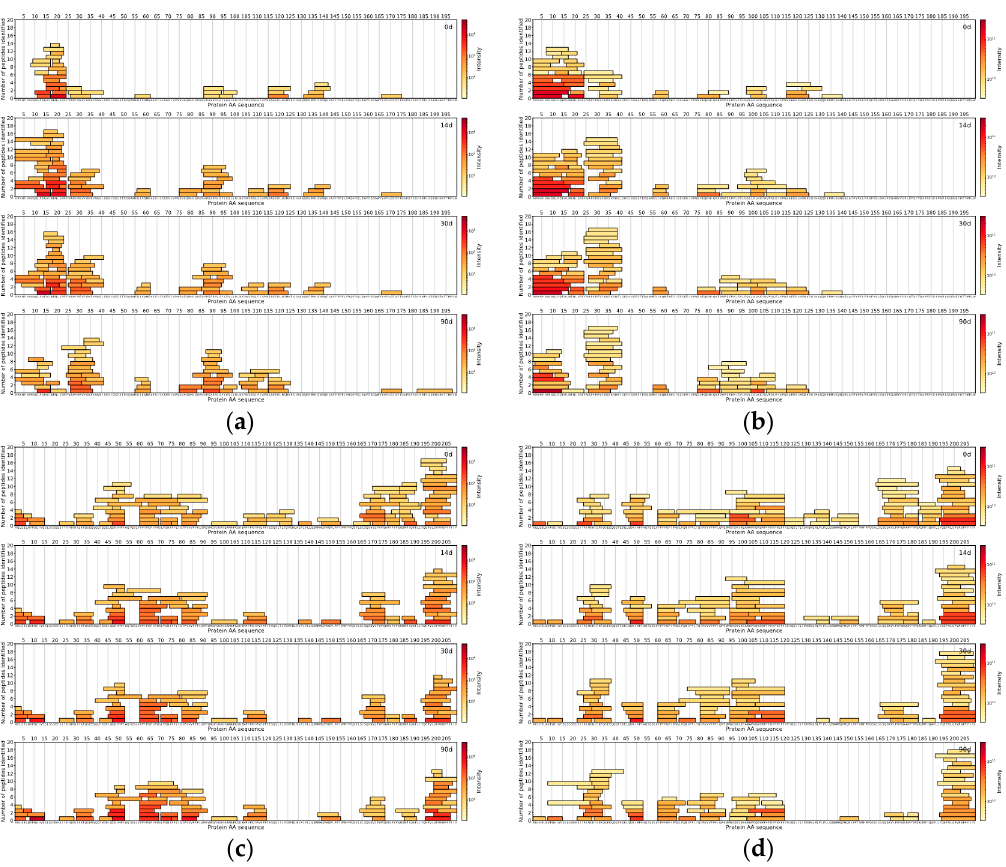
Figure 4. Cheese 1 α s1 -CN: ( a ) data-independent acquisition (DIA)-MS and ( b ) data-dependent acquisition (DDA)-MS. Cheese 1 β -CN: ( c ) DIA-MS and ( d ) DDA-MS. The X -axis represents the casein amino acid sequence, the Y -axis represents a number of peptides and colour represents the logarithmically scaled intensity of